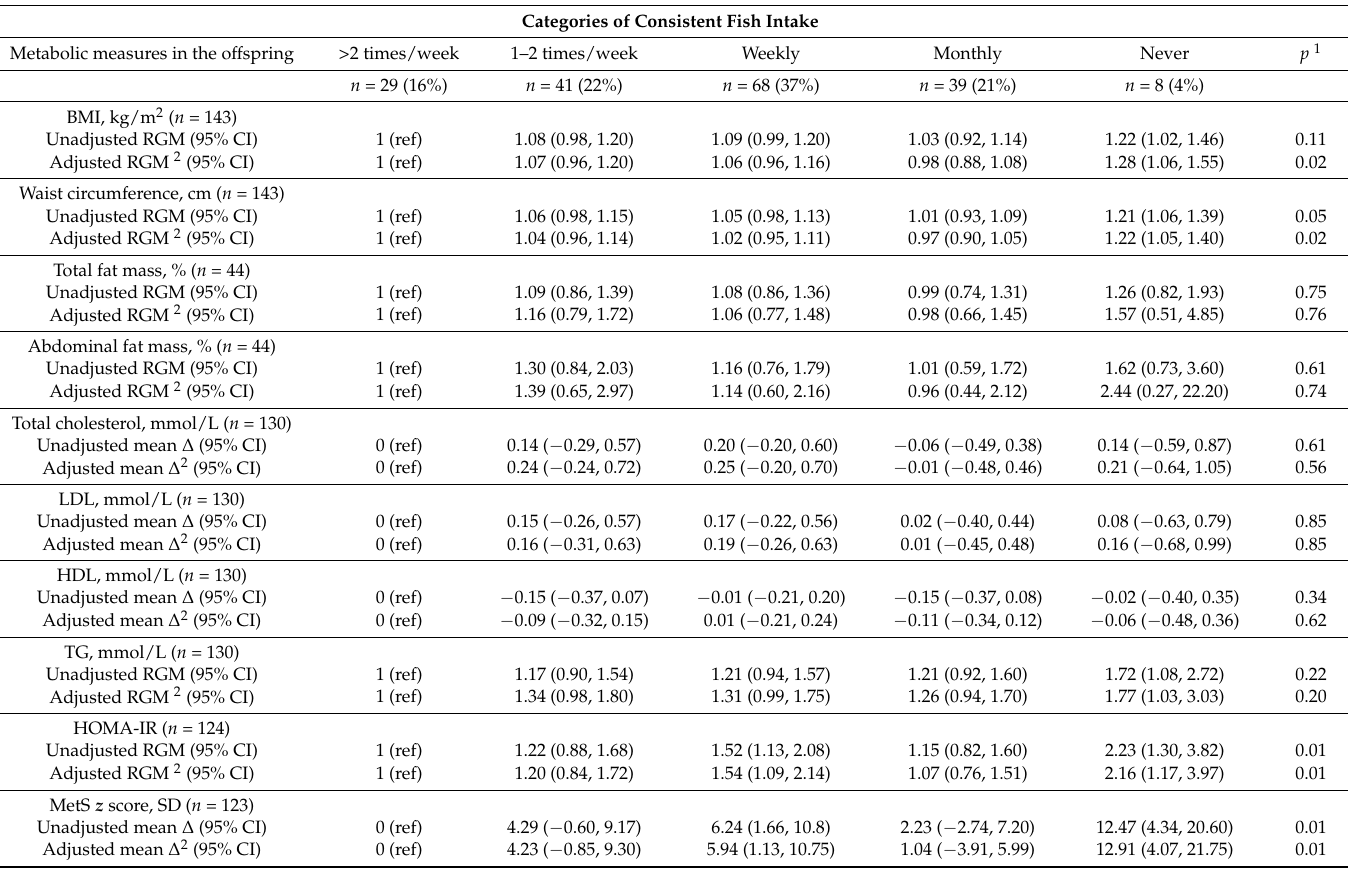
Table 3. The association between consistent fish intake in gestational week 12 and 30 and offspring metabolic parameters at age 9–16 years in GDM-exposed mother-offspring